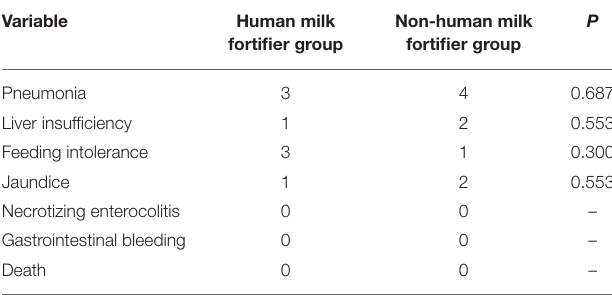
TABLE 4 | Comparison of complications between the two groups 1 month after the